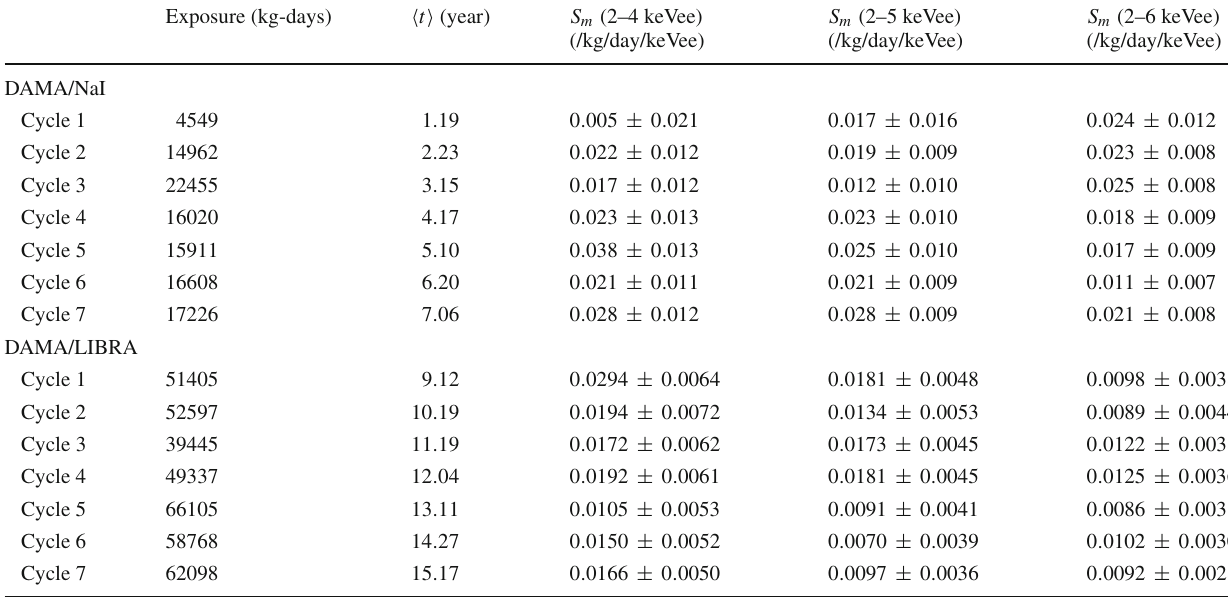
Table 3 The per-cycle modulation amplitudes as determined by the DAMA collaboration, allowing the period and phase to be freely fit in addition to the amplitude. Mean cycle times and amplitudes are taken